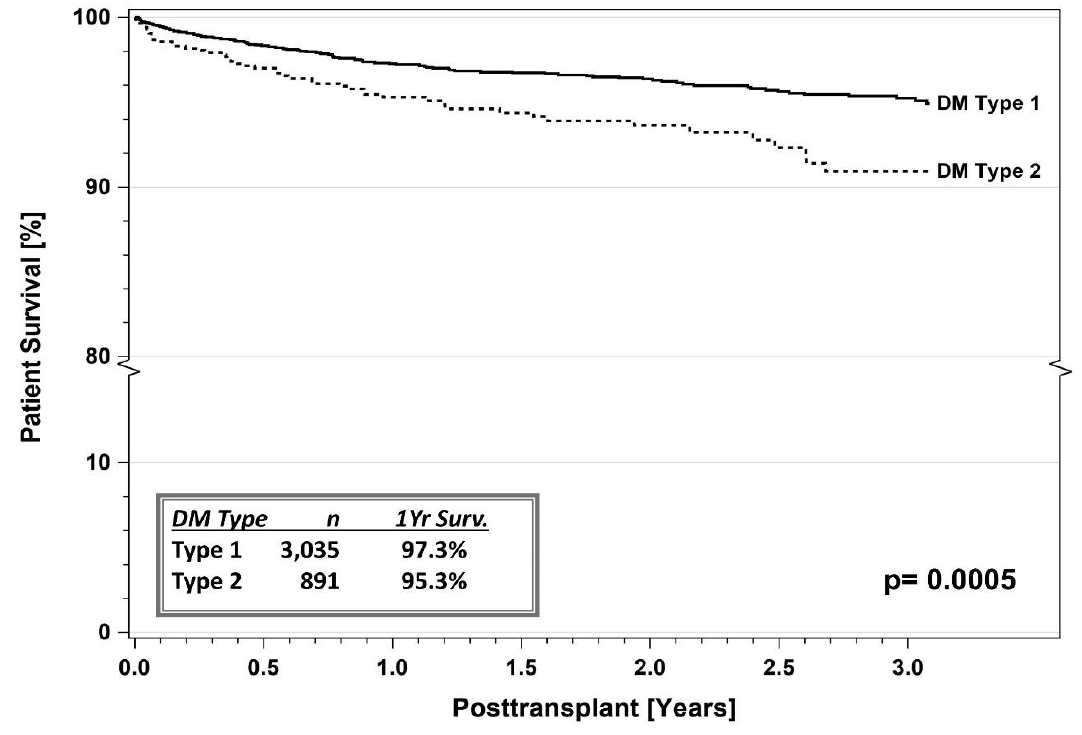
Figure 5. SPKT patient survival according to diabetes type in the latest era (1 January 2017 – 31 December 2021) for US cases as reported to the IPTR. Surv. = Survival